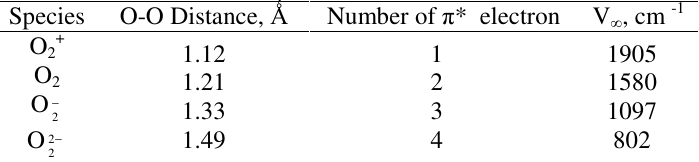
Table 2. Various bond values for dioxygen species.